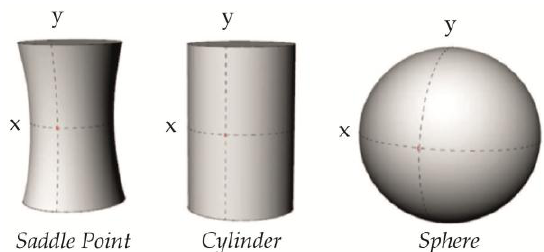
Figure 4. Three cardinal types of geometrical curvature. The geometrical point in each shape is marked with red, where the two principal radii of curvature intersect. The curvature of the x -axis in each figure is assumed to be C in each geometrical point, whereas the curvature of the y -axis ranges from −C in the saddle-point, over 0 in the cylinder, to +C in the sphere. Hence, the mean curvatures are calculated as 0, 0.5 × C, and C, respectively.